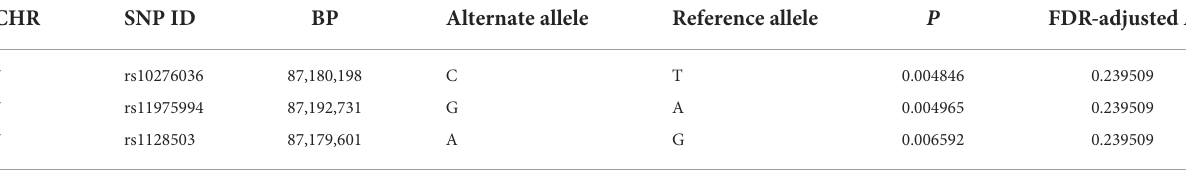
TABLE 2 Genetic variants associated with seizure